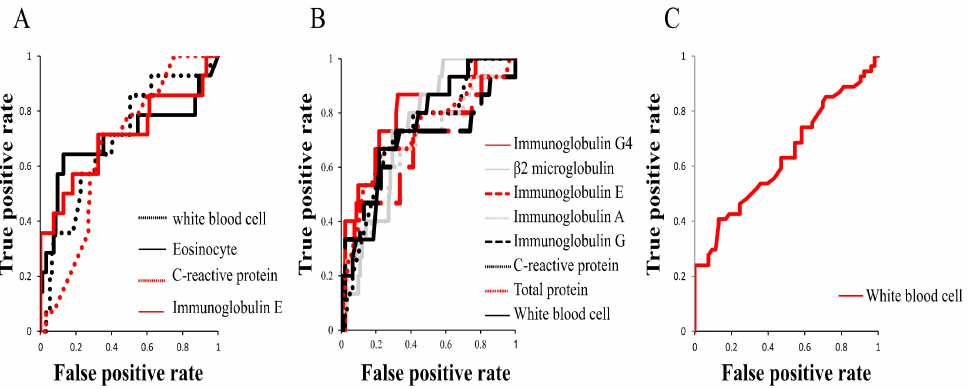
Figure 2. ROC curves for extraocular muscle enlargement, worsened best corrected visual acuity (BCVA), and lesion above the neck excluding LG and SG using significantly different laboratory findings obtained from comparison of laboratory findings in patients with and those without specific clinical features. ( A ). Receiver operating characteristic (ROC) curves for extraocular muscle enlargement using WBC count, Eo count, C-reactive protein (CRP), and IgE. Area under the ROC curve (AUC) of IgE is the largest among the four markers (0.71). Cutoff value of IgE is 425 IU / mL, with the highest odds ratio. ( B ). ROC curves for worsened BCVA using serum IgG4, β 2MG, serum IgE, serum IgA, serum IgG, CRP, serum TP, and WBC count. AUC of IgG4 is the largest among the eight markers (0.80). Cutoff value of IgG4 is 713 mg / dL, with the highest odds ratio. ( C ). ROC curve for lesion above the neck excluding LG and SG using peripheral WBC count. AUC of WBC is 0.63. Cutoff value of WBC count is 6700 number / µ